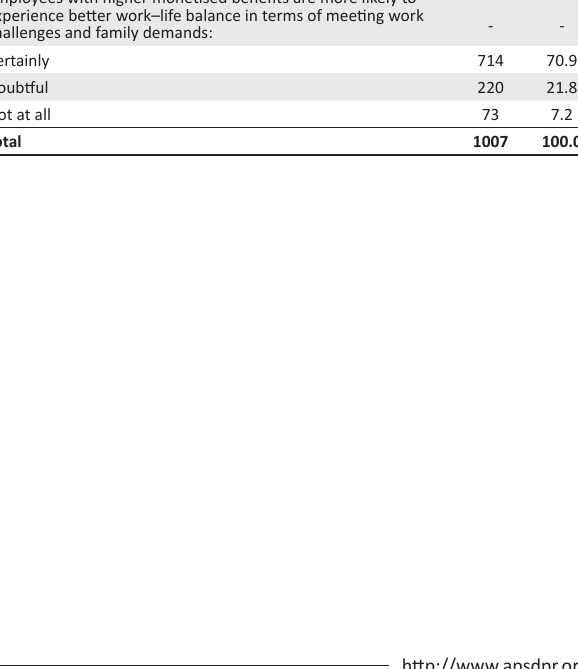
TABLE 3-A1: Respondents’ view on the effect of the Monetisation Policy on employees . Questionnaire item and response categories